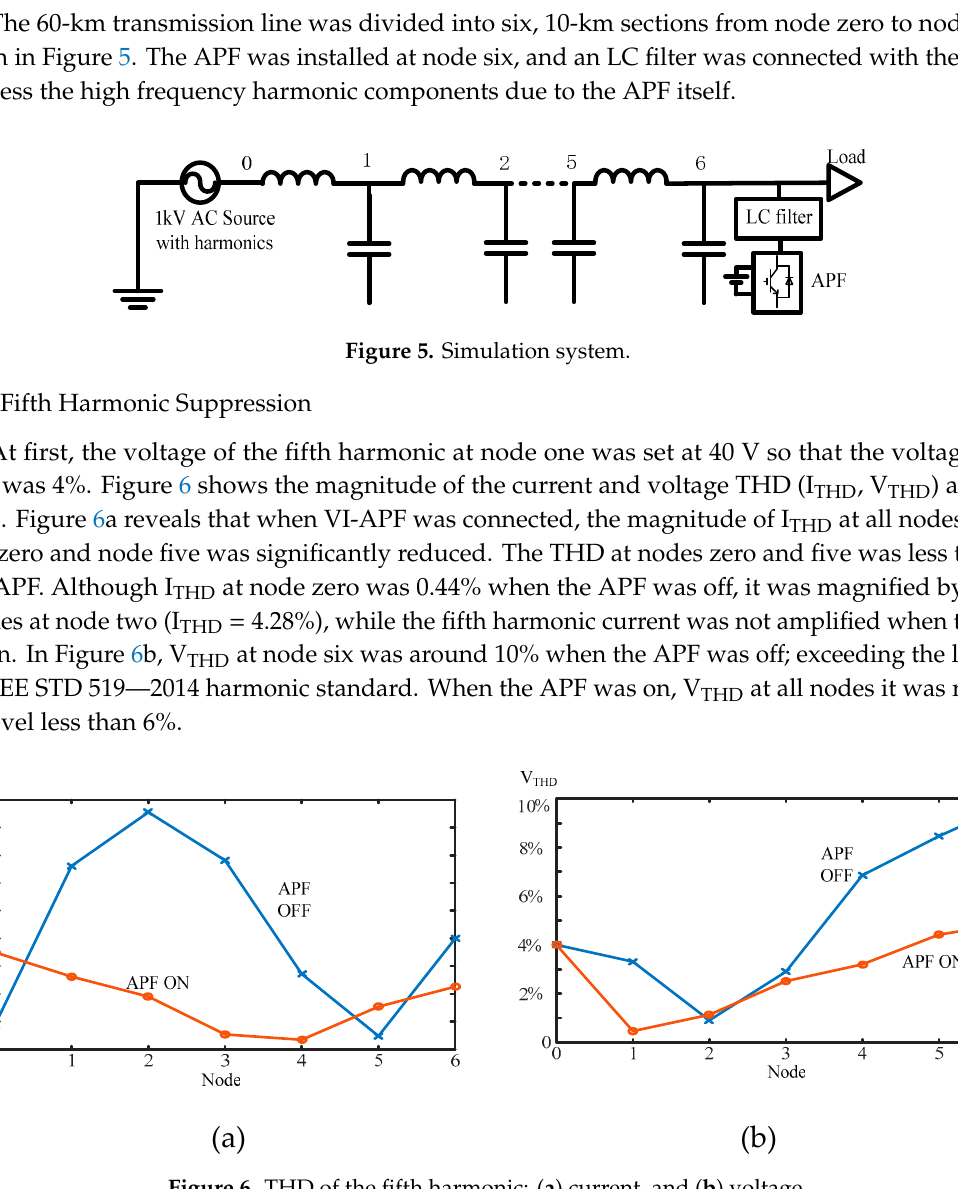
Figure 6. THD of the fifth harmonic: ( a ) current, and ( b ) voltage.